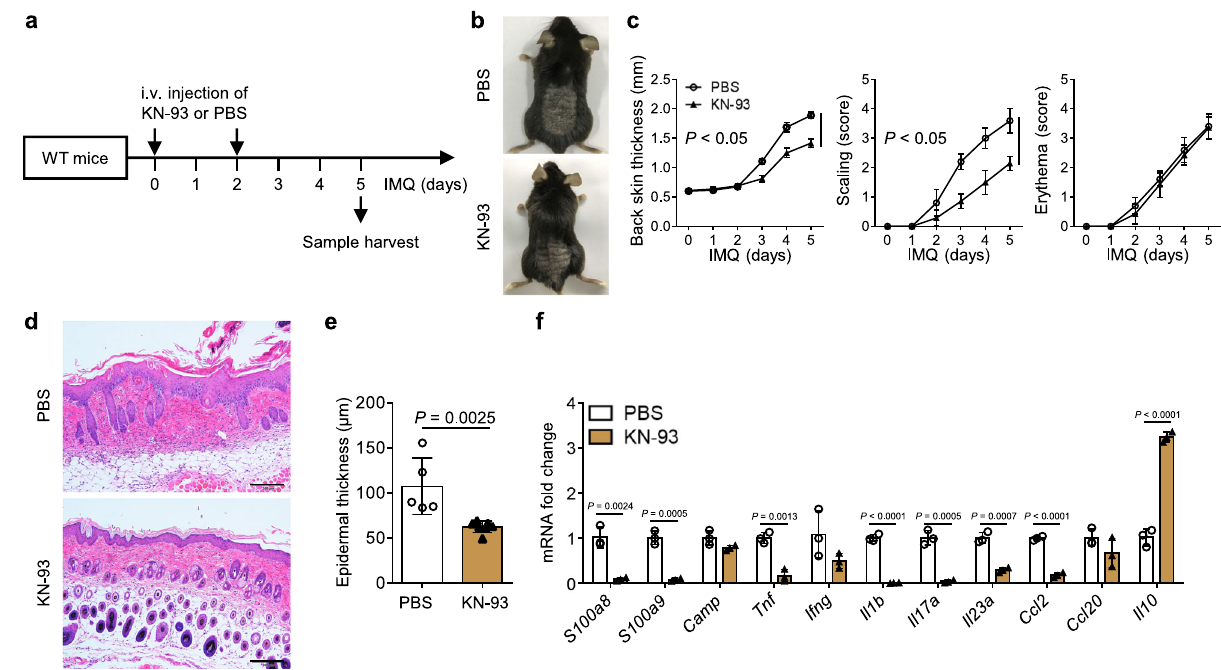
Fig. 9 | CaMK4 inhibitor ameliorates IMQ-induced psoriasis. a Schematic representation of the mouse model. WT mice were topically treated with 62.5mg IMQ on shaved back skin daily for 5 consecutive days. KN-93 (0.24mg per mouse) or PBS wasintravenously injected into the mice 1h beforeIMQtreatment on day 0 and day 2. Samples were harvested on day 5 for subsequent experiments. b Representative photos of mouse back skin. c Scoring curves of back skin thick- ness, scaling, and erythema. d H&E staining of skin sections. Scale bar=200 μ